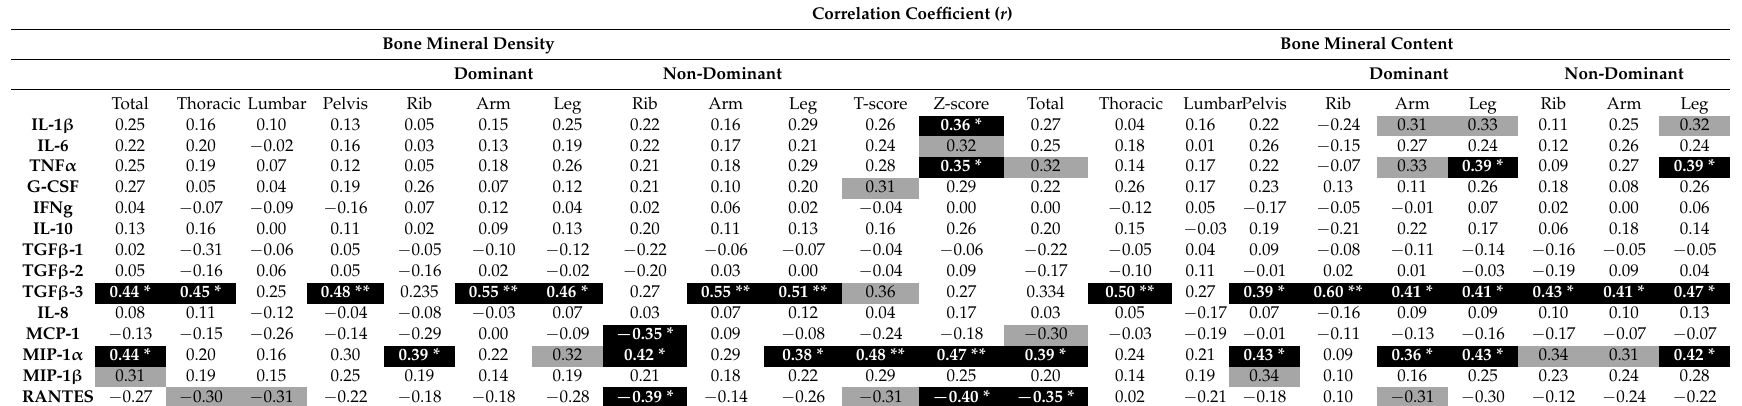
Table 4. Spearman rank order correlations between serum cytokine concentrations in 33 participants against participants’ bone